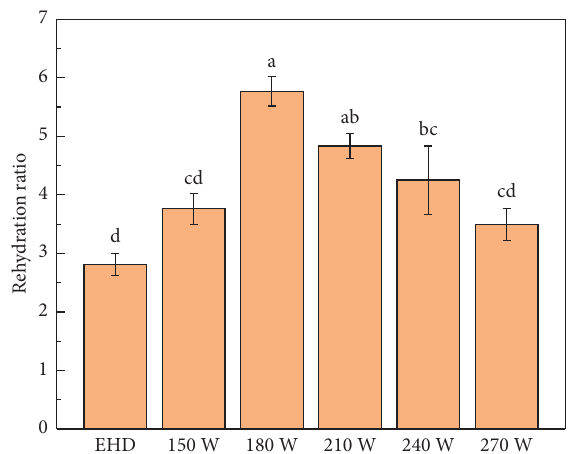
Figure 6: Diagram of the rehydration rate change in potato slices under different ultrasonic pretreatment conditions. Data are shown as the mean ± SD. For each response, means with different low- ercase letters are significantly different ( p < 0 . 05).